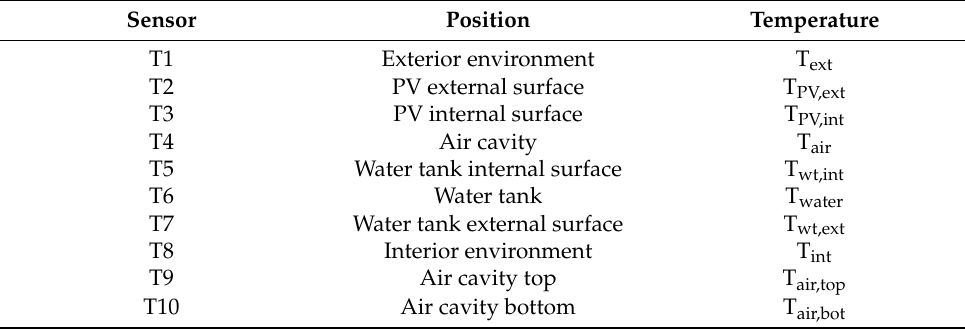
Table 3. Nomenclature of the experimental setup (temperature sensors).